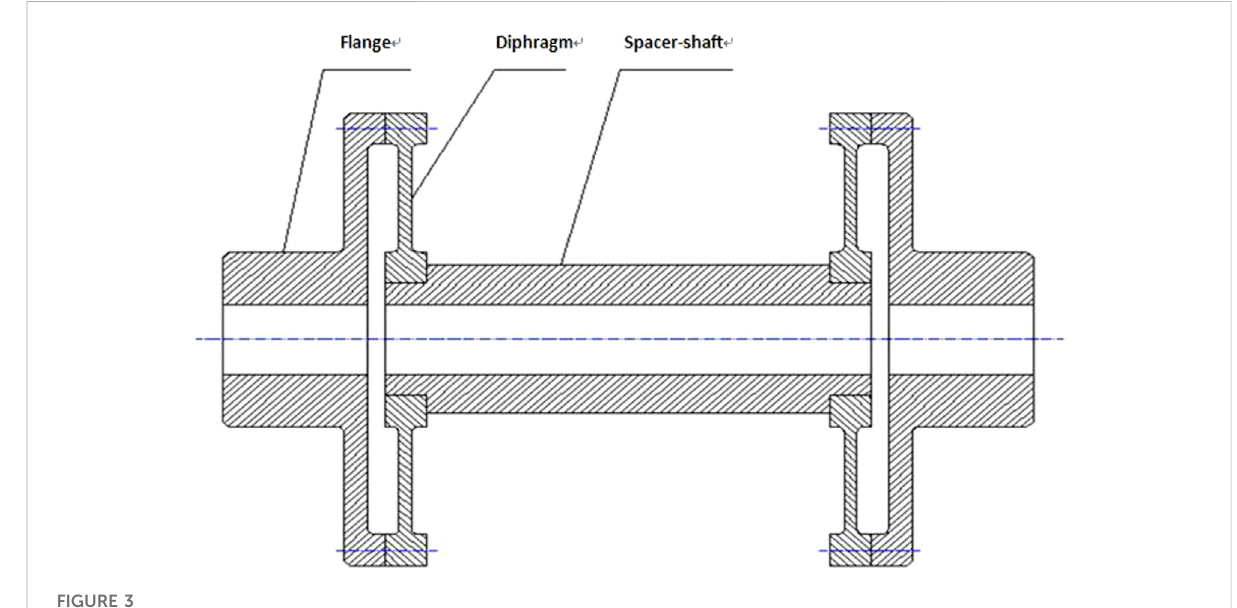
FIGURE 3 Diaphragm coupling connected by